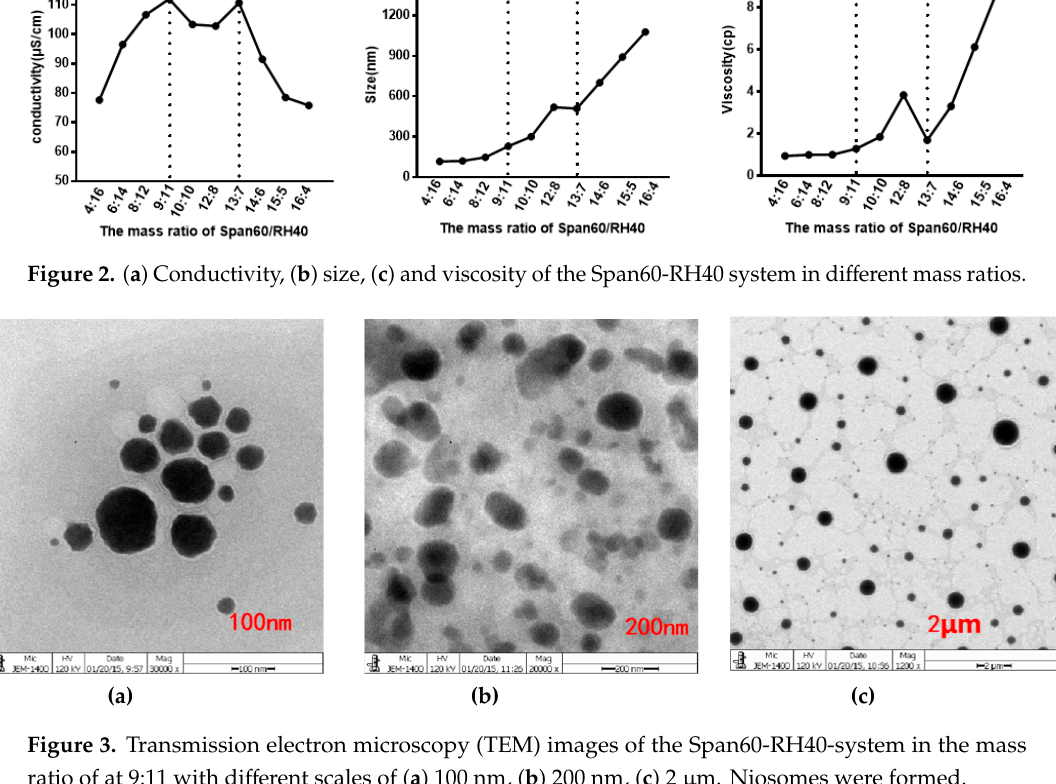
Table 3. Size and zeta potential of empty niosomes and quercetin-niosomes. Sample